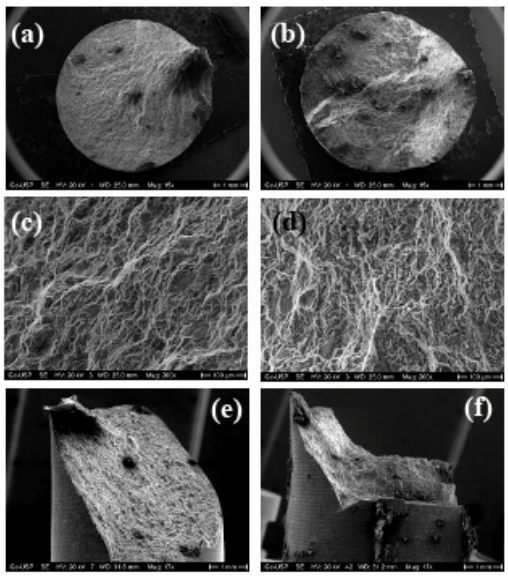
Figure 12. SE-SEM micrographs of the fracture surfaces of the as-received AZ61 alloy: a) cross-section; specimen tested in air; b) cross section; specimen tested in 0.1 M NaCl solution; c) high magnification view of (a); d) high magnification view of (b); e) side view; specimen tested in air; f) side view; specimen tested in 0.1 M NaCl.